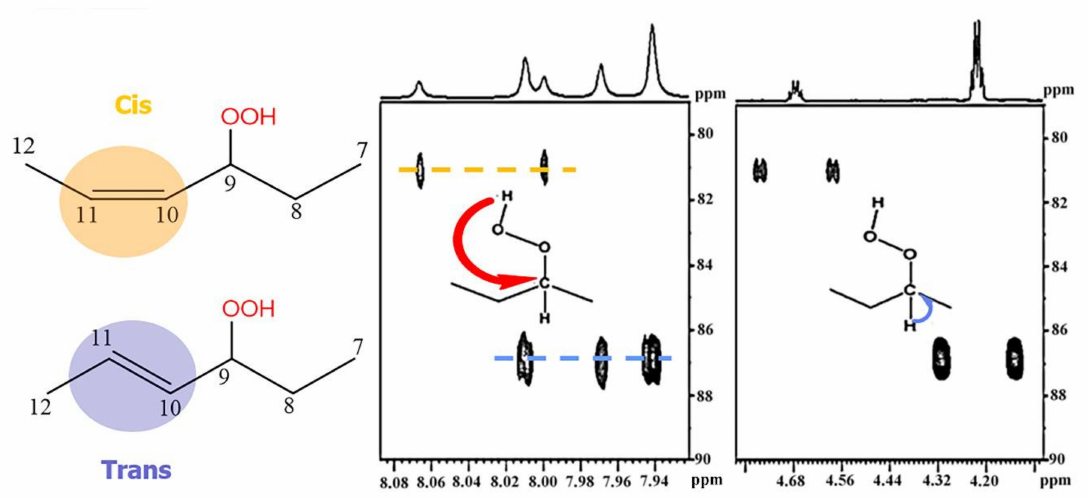
Figure 38. Selected region of the 800 MHz 1 H– 13 C HMBC NMR spectrum of 45 mg of methyl oleate in CDCl 3 subjected to heating at 70 ◦ C for 135 h. Number of scans, 32; number of increments, 256; total experimental time, 5 h 53 min [137]. Table 6. Comparison of the quantification data a of hydroperoxides produced during oxidation